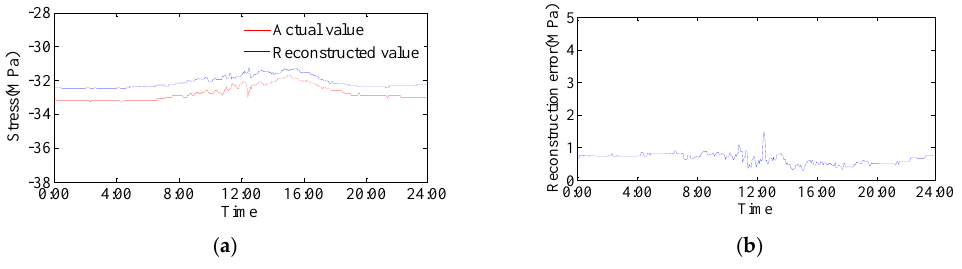
Figure 7. The reconstructed value and the actual value using data from 7 May 2014 to 12 May 2014: ( a ) the curve of reconstructed value and the actual value; and ( b ) the curve of reconstruction error. The correlation model using stress monitoring data from 7 May 2014 to 14 May 2014 is: